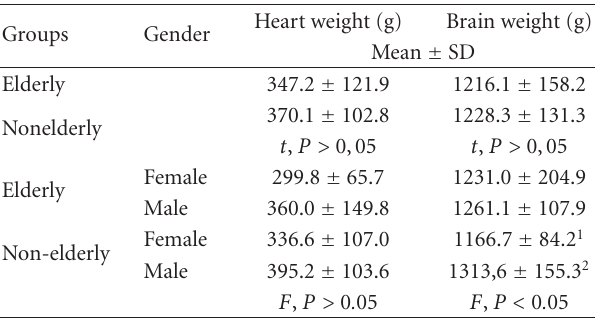
Table 1: Heart and brain weight according to gender of the elderly and non-elderly patients with cysticercosis.